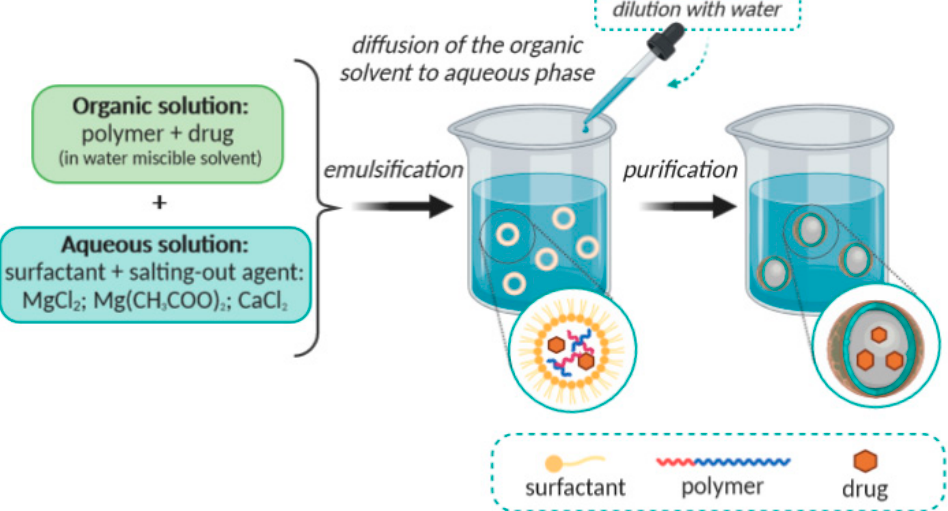
Figure 4. Schematic representation of the emulsification/reverse salting-out method.